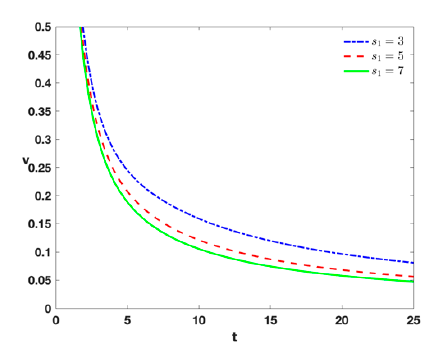
k 2 = 1, m 2 = 1, s 1 = 3 and different values of β . ( a ) s 2 = 0 and ( b ) s 2 = 1.